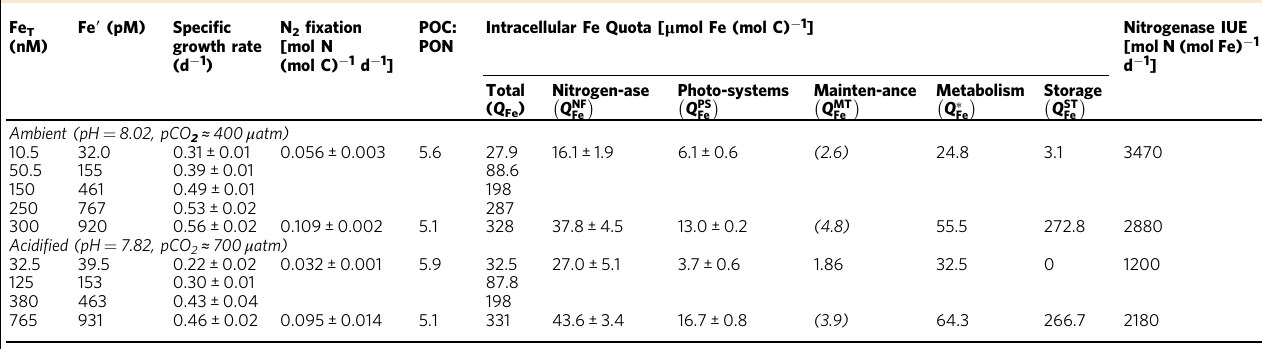
Table 1 Treatments and results of Trichodesmium manipulation experiments Fe T